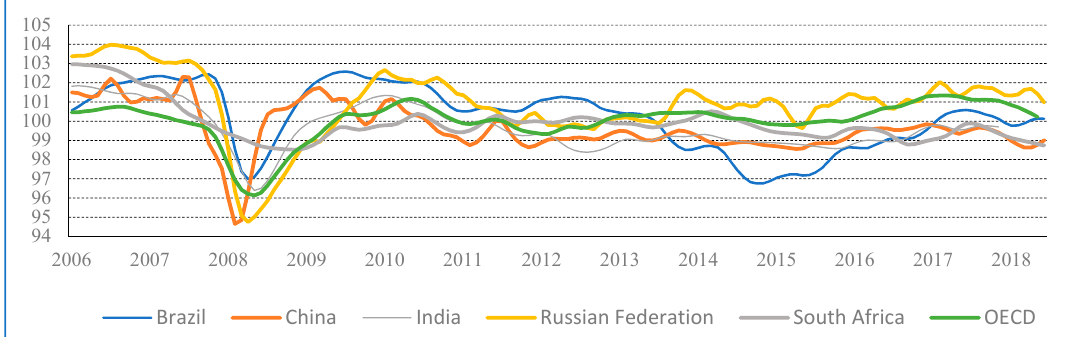
Figure 4. Portfolio, net inflows (as % of GDP). Source: Own elaboration based on World Development Indicators (World Bank). Int. J. Financial Stud. 2019 , 7 , x FOR PEER REVIEW